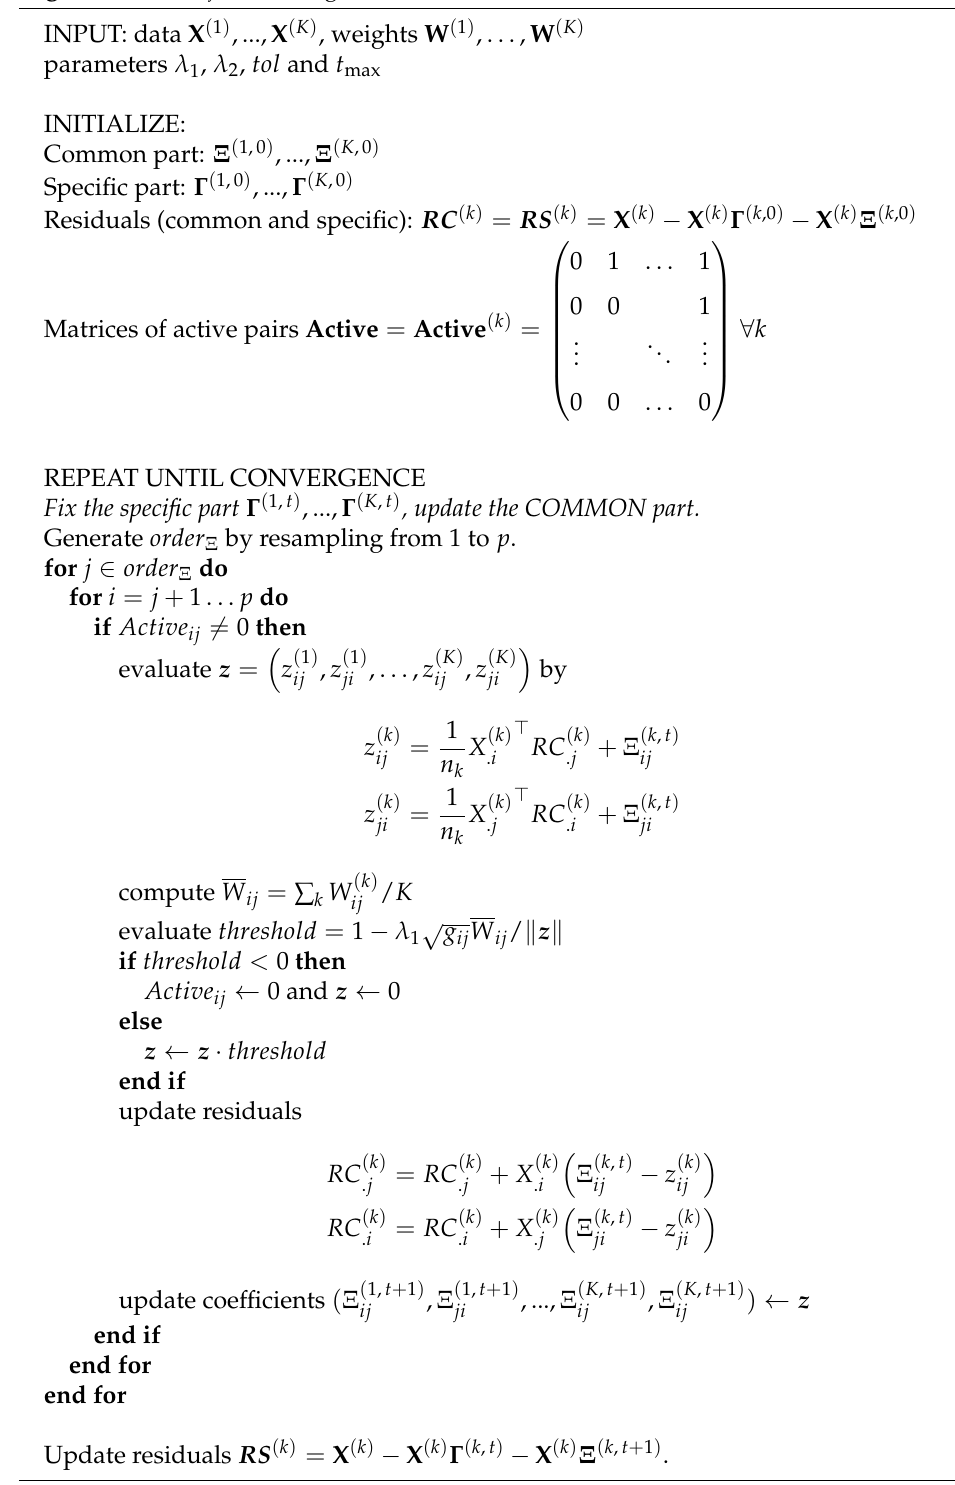
Algorithm 1 The jewel 2.0